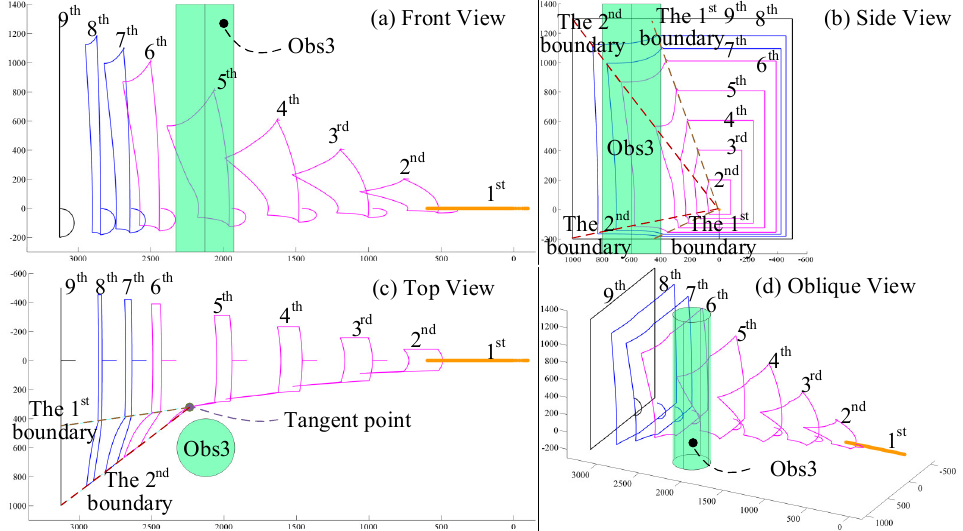
Figure 13. Motion paths of 9 key points in obs3. ( a ) Front view; ( b ) Side view; ( c ) Top view; ( d ) Oblique view.